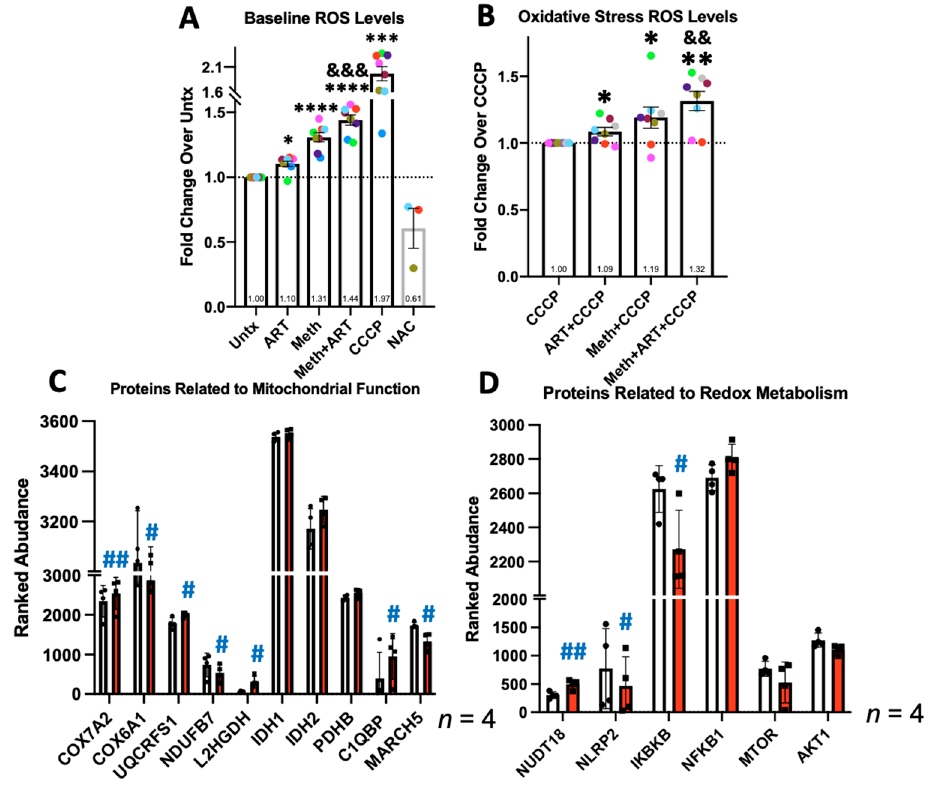
Figure 3. Total reactive oxygen species (ROS) in HIV-infected MDM were detected by a fluorometric plate reader assay. CM-H2DCFDA dye in culture media was added for 1 h followed by incubation in PBS, 30 µM of CCCP, or 5 mM of N-acetylcysteine (NAC) for 1 h, followed by detection of fluorescence by fluorometry. ( A ) ROS levels at baseline without stimulation with untreated cells (Untx) set to 1.0 in each experiment. ( B ) ROS levels in cells stimulated with CCCP for 1 h with CCCP alone set to 1.0 in each experiment. ( C , D ) Differentially expressed proteins detected by mass spectrometry related to mitochondrial function and cellular redox metabolism, HIV Untx in white bars and HIV Meth in red bars. n = 4–8; * p < 0.05, ** p < 0.01, *** p < 0.001, **** p < 0.0001, one-sample t test or Wilcoxon signed rank test. && p < 0.01, &&& p < 0.001 Meth + ART compared to ART alone by one-way ANOVA. # p < 0.05, ## p < 0.01 paired t test. Error bars represent SEM for ROS data and SD for proteomics